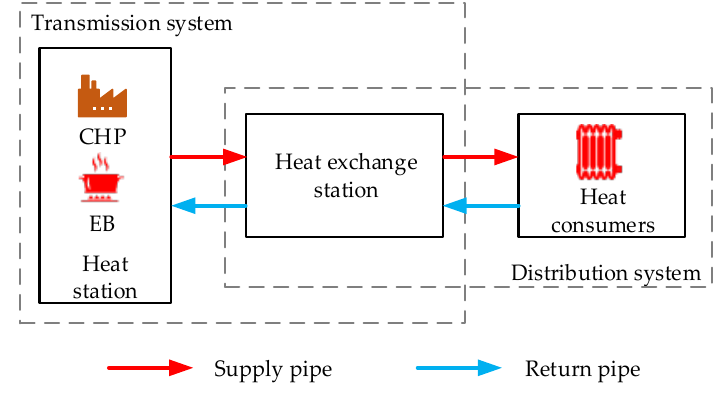
Figure 2. Structure of heat network.